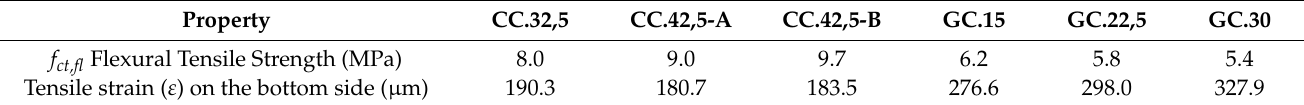
Table 6. Maximum flexural tensile strength and tensile strain distortion on the bottom of prismatic specimens.